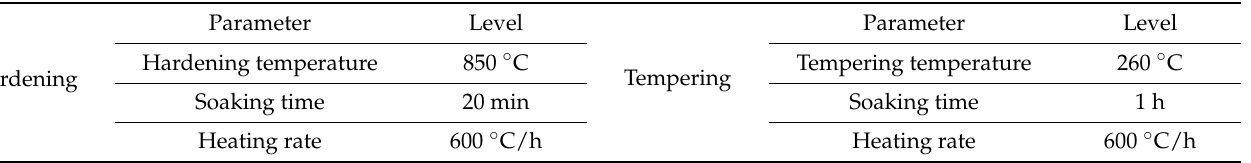
Table 2. Heat treatment